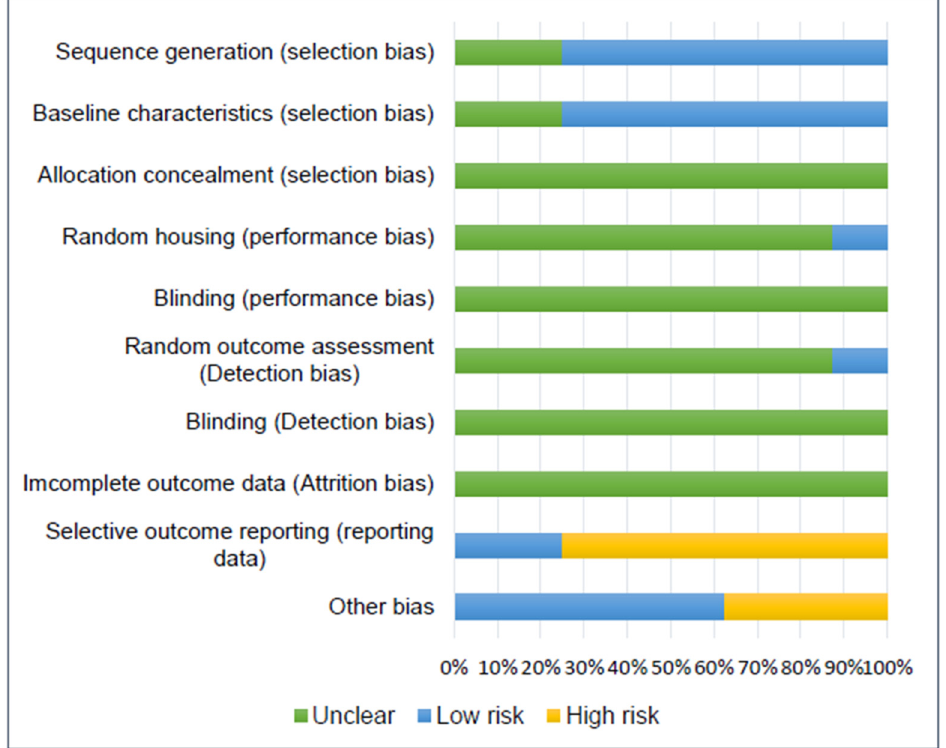
Figure 2. Risk of bias chart for assessing the methodological quality of the 8 papers reporting in vivo studies included in this systematic